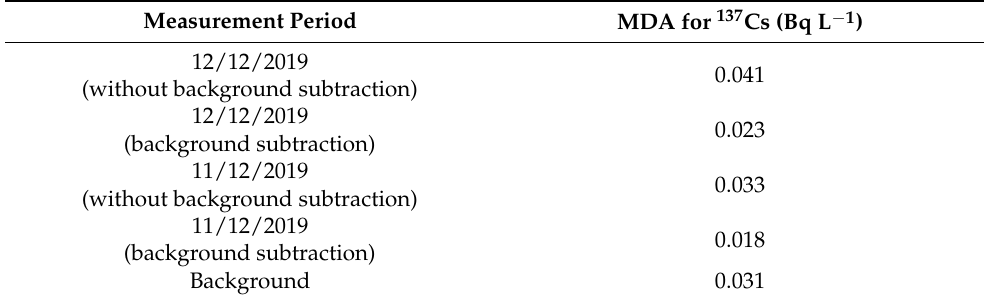
Table 2. MDA values for 137 Cs with and without background subtraction for two different measure- ments during precipitation events (24 h period with and without background